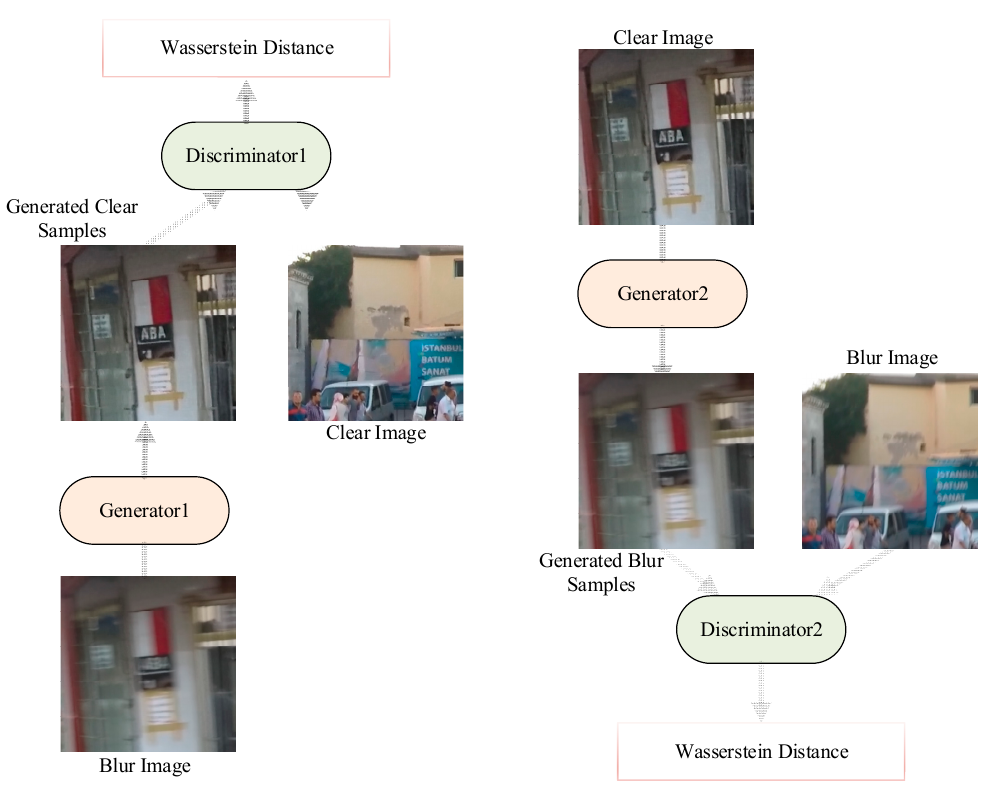
Figure 4. The calculation process of adversarial loss.